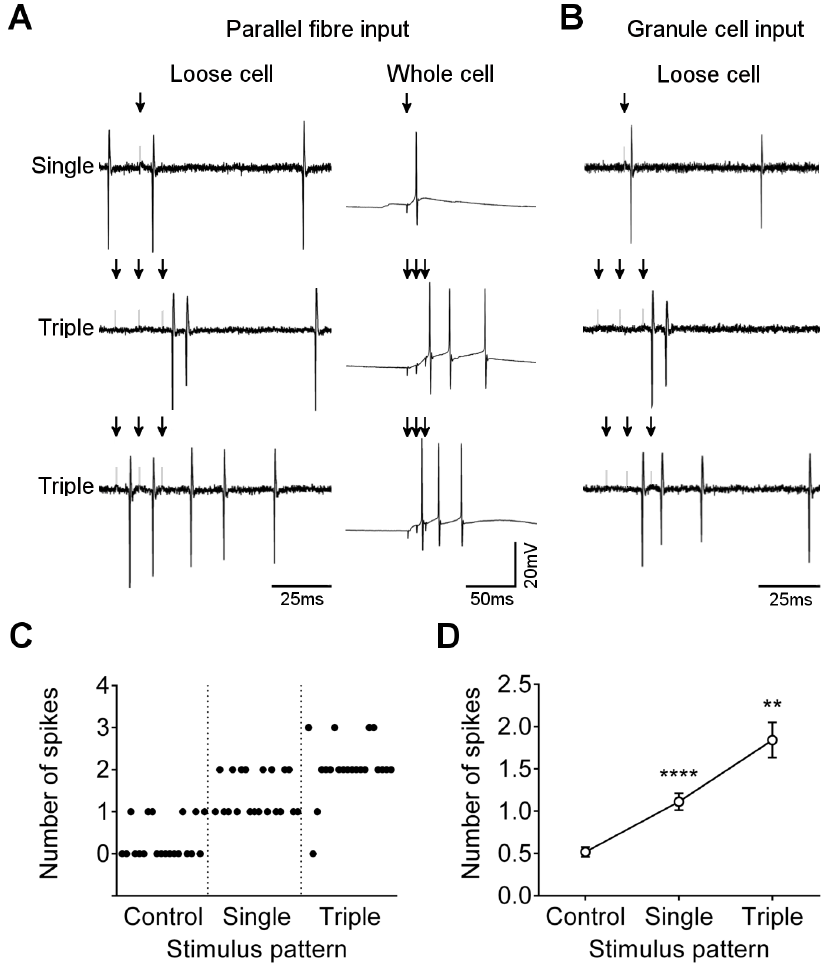
Figure 4. Effect of stimulus number on number of post-stimulus spikes. A) Loose cell (left panels) and whole cell (right panels) recordings from representative Purkinje neurons during stimulation at 25 m A in the molecular layer (arrow) with a single pulse (upper trace), or three pulses with 10 ms interval (lower traces). Lower two traces show different outcomes observed when spikes follow the final stimulus (middle trace) or when spikes are added during and after the stimulus train (lower trace). B) Representative loose cell attached recordings under the same conditions as panel A, but with stimulation in the granular layer. C) Raster plot of number of post-stimulus spikes for 20 representative responses during no stimulation, stimulation with a single pulse, or stimulation with 3 pulses. D) Mean 6 s.e.m. number of post-stimulus spikes with single or triple pulses (note that only spikes that follow the end of the stimulus train are counted). ****p , 0.0001 compared to control, **p=0.002 compared to single pulse. Multiple comparisons ANOVA with Tukey’s test for pairs (adjusted p